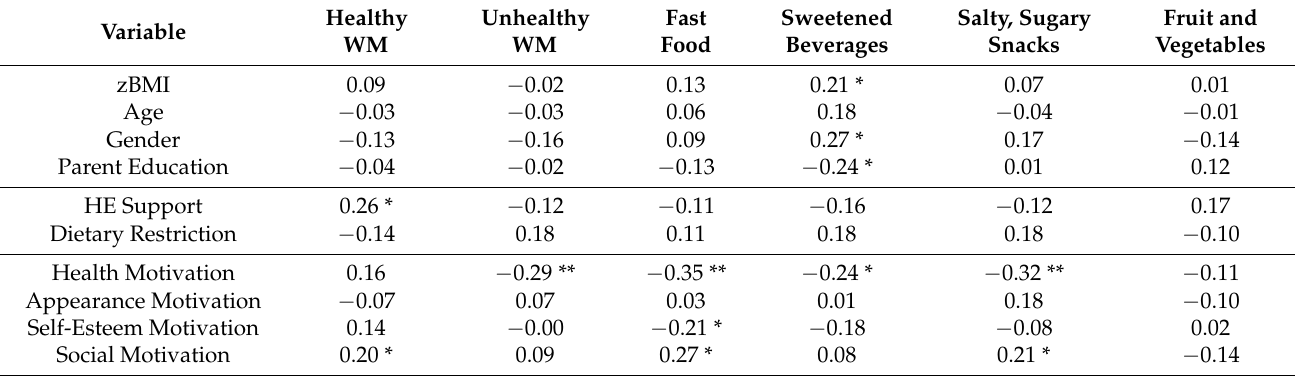
Table 2. Bivariate correlations of demographic, family, and motivation variables with dietary behavior and weight management strategies.